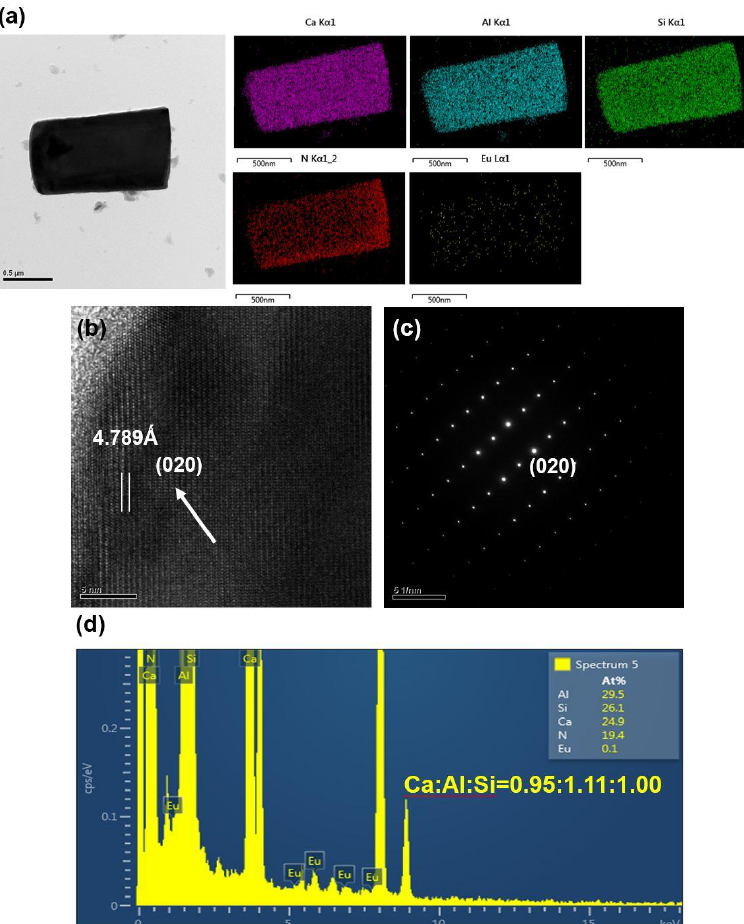
Figure 7. ( a ) TEM image and corresponding element mapping of Ca, Al, Si, N, and Eu; ( b ) HRTEM image; ( c ) SAED pattern; and ( d ) element analysis of a bar-like particle (showing it to be CaAlSiN 3 :Eu 2+ ) in a product synthesized with Ca:Al:Si:Si 3 N 4 :Eu 2 O 3 :NaN 3 :NH 4 Cl = 1.5:1.0:0.25:0.25:0.02:3.5:0.6.